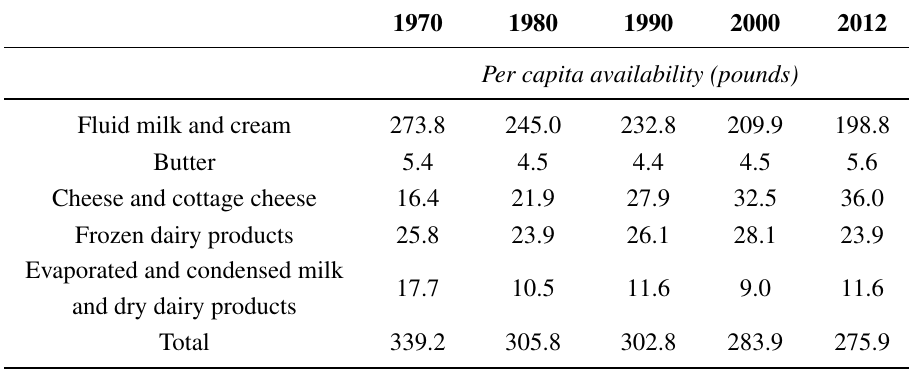
Table 5. Milk and dairy products consumption in the USA (except cheese) has steadily declined since the mid-1980s. (USDA, Economic Research Service, Food Availability (Per Capita) Data